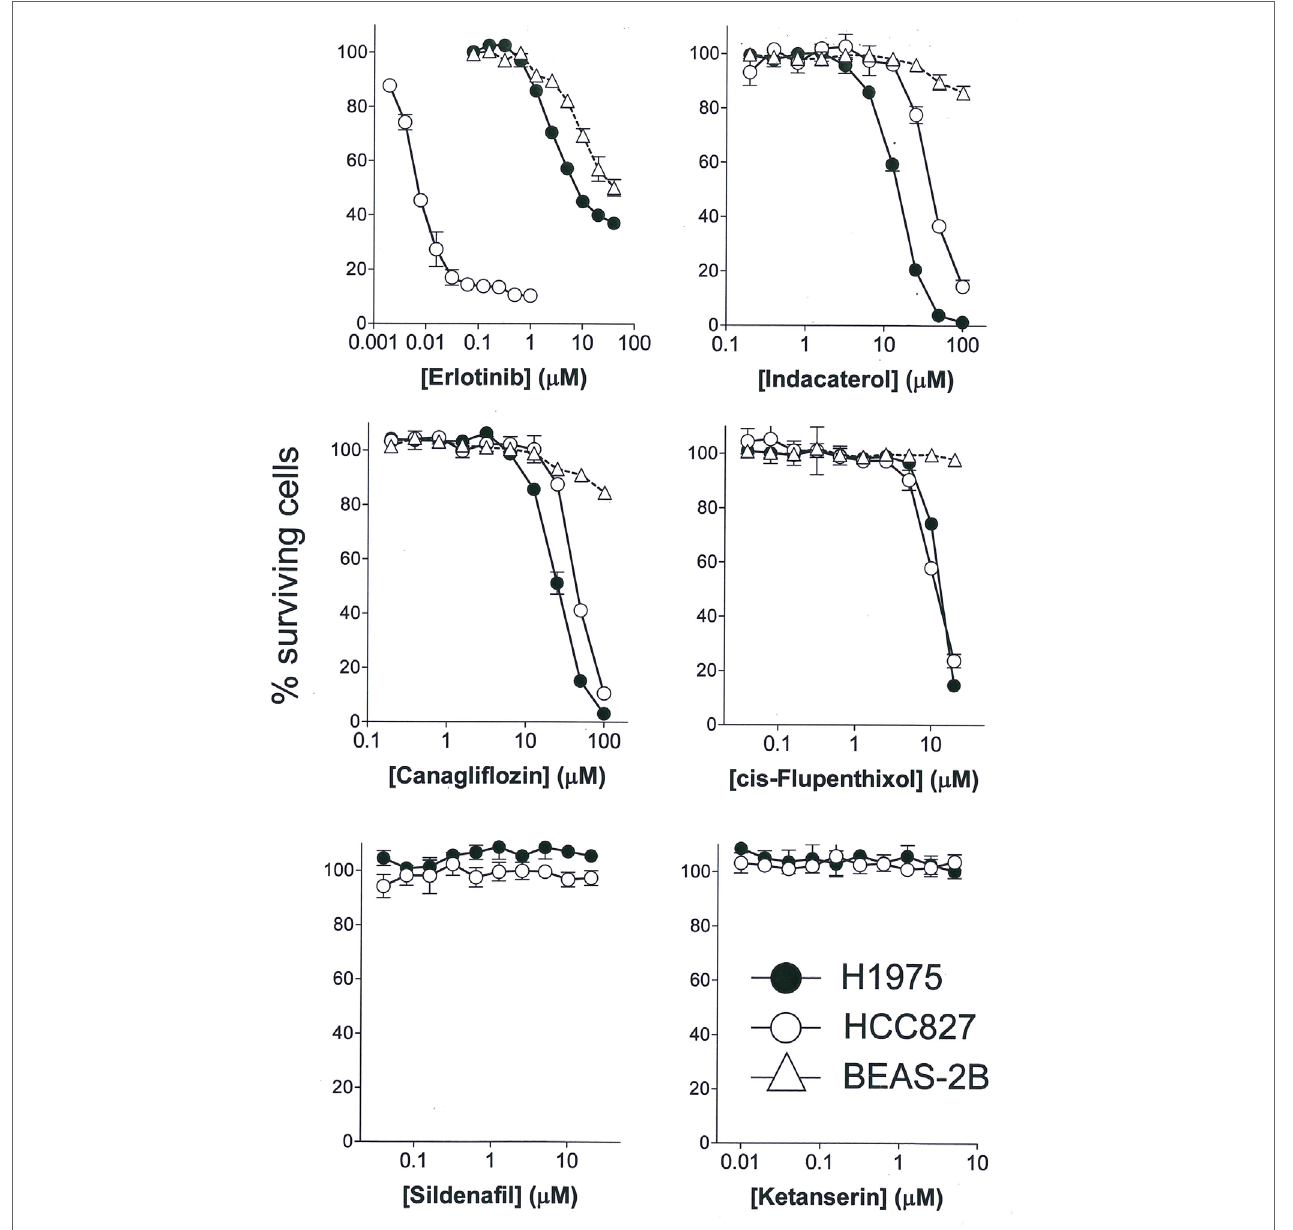
FigUre 1 | Cytotoxicity of the drugs tested. Cytotoxicity of three positive hits (indacaterol, canagliflozin, and cis -flupenthixol) and two negative drug candidates in the indicated cell lines was determined by the sulforhodamine B assay. A representative first-generation epidermal growth factor tyrosine kinase inhibitor (erlotinib) was also evaluated as control for